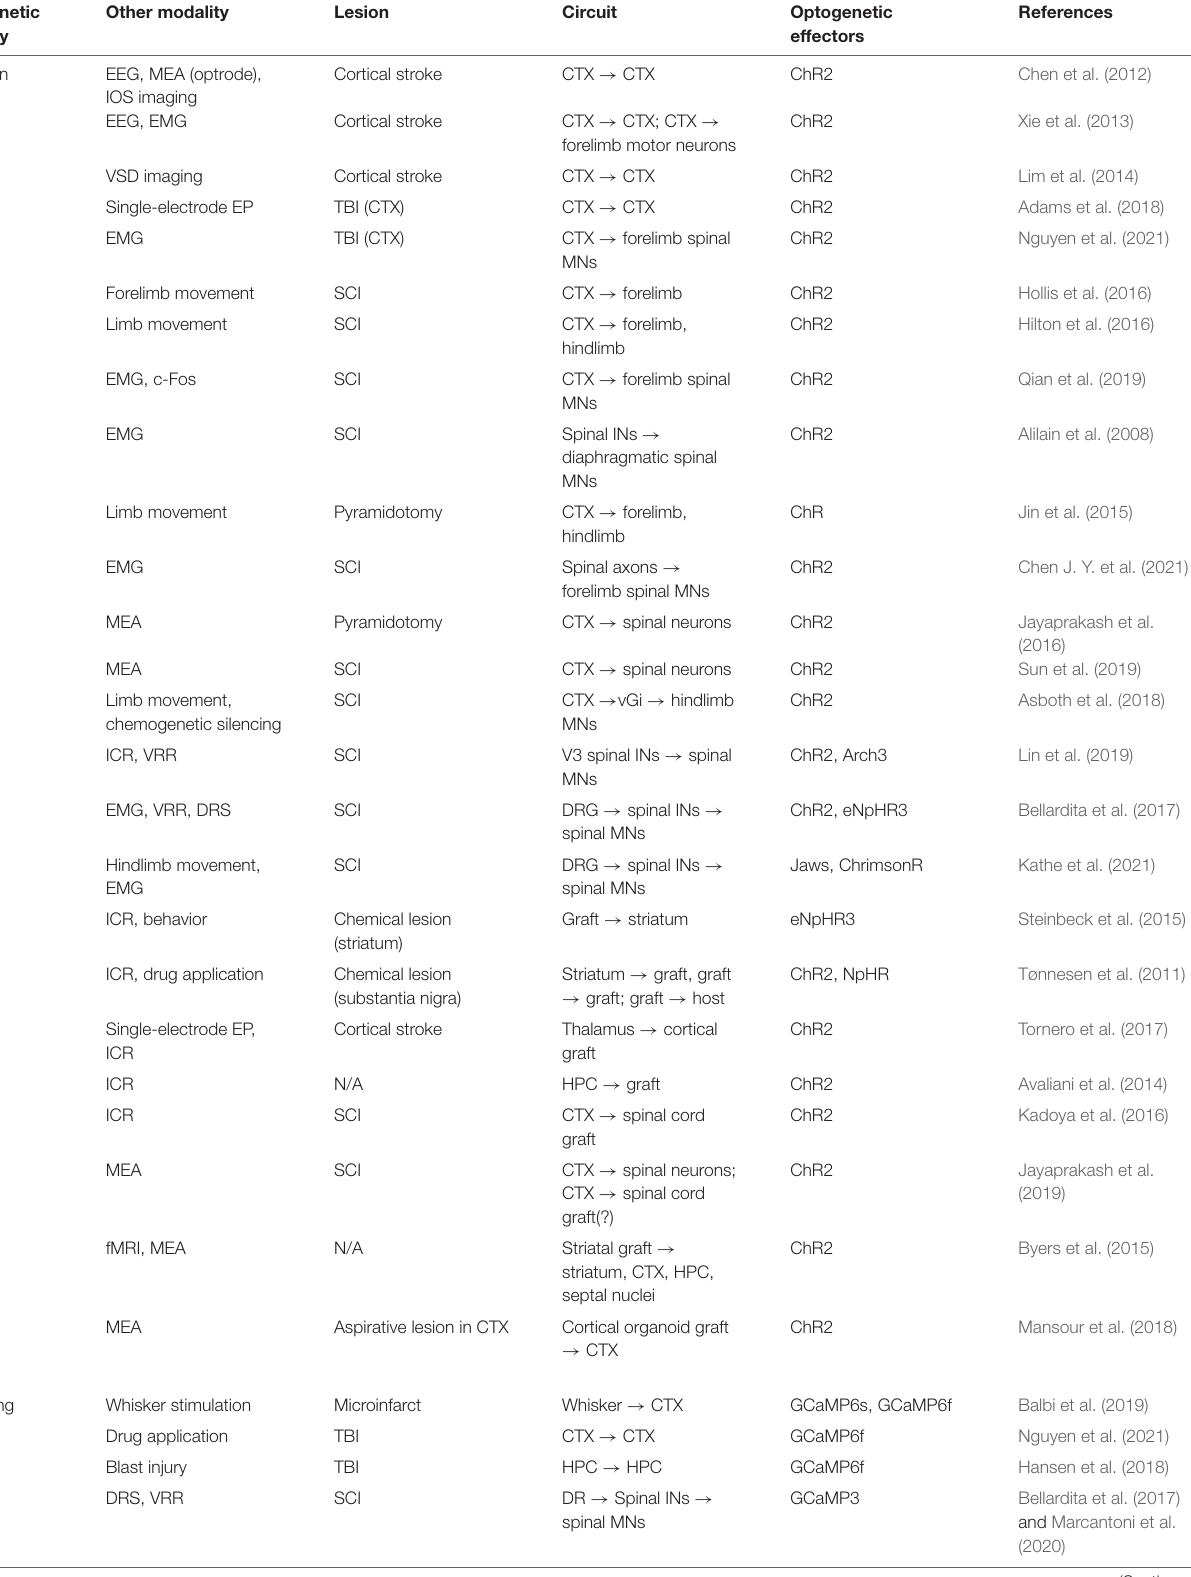
TABLE 1 | List of studies utilizing optogenetic methods to interrogate reorganizing circuitry after acute trauma and intervention. Optogenetic